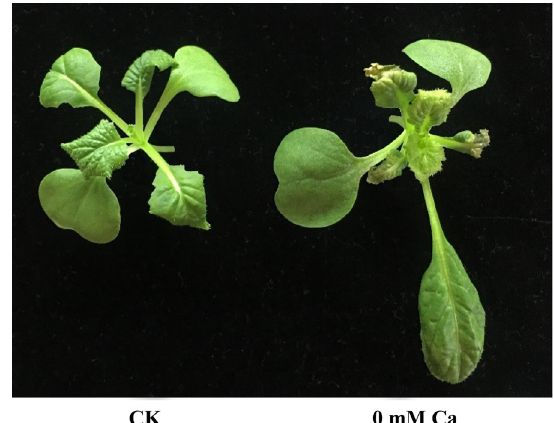
Figure 1. Phenotype comparison of Chinese cabbage. CK indicates Chinese cabbage grown on standard Hoagland medium, 0 mM Ca stands for Chinese cabbage grown on Hoagland medium (without Ca 2+ ). The samples were collected on the 21st day after germination.